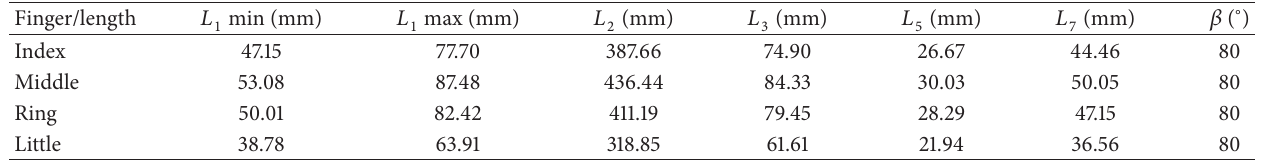
Table 3: Construction parameters for the four R-RRT mechanisms.